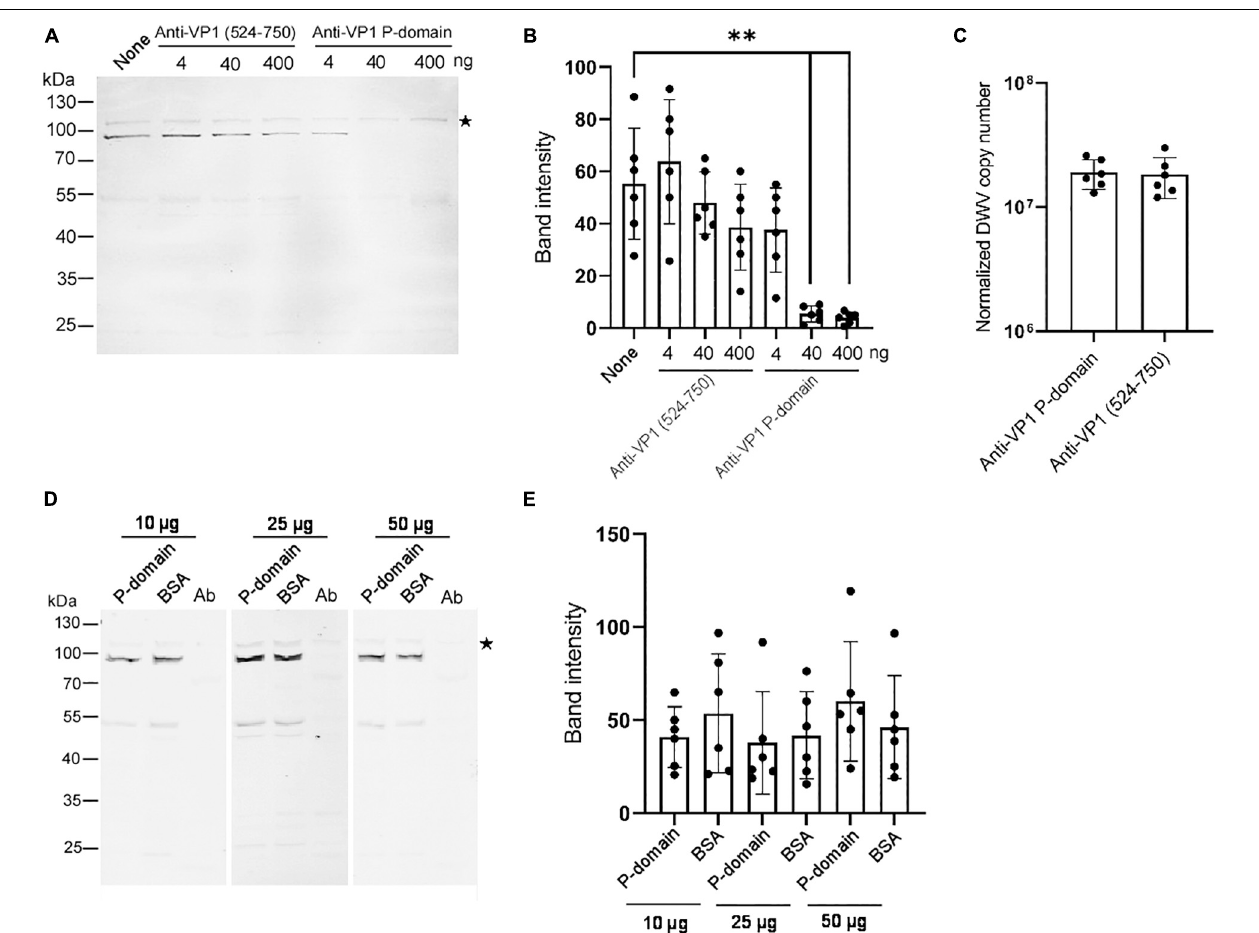
FIGURE 3 | Essential role of the VP1 P-domain in DWV infection. (A) Effect of preincubation of DWV with 4, 40, or 400 ng of either anti-VP1 (524–750) or anti-VP1 P-domain antibody before infection on RdRP synthesis. DWV with no antibody preincubation (none) was used as a control. (B) Band intensity of the RdRP precursor was compared between the seven groups with the one-tailed Dunnett test. P -values between none and 40 or 400 ng of anti-VP1 P-domain antibody are < 8.3 × 10 − 6 and < 5.5 × 10 − 6 , respectively (**). Mean values ± SD (error bars) are shown ( n = 6). (C) Entry of DWV pre-incubated with 40 ng of either anti-VP1 (524–750) or anti-VP1 P-domain antibody to the pupal head tissues was compared (normalized copy number of DWV inside the infected cells). The difference between the two groups was not statistically significant. Mean values ± SD (error bars) are shown ( n = 6). (D) Effect of preincubating pupal head tissues with 10, 25, or 50 µ g of purified P-domain protein before DWV infection on RdRP synthesis. BSA was used as control. Lysate of abdomen from the same pupa (Ab) was also analyzed to confirm the lack of replication of endogenous DWV. (E) Band intensity of RdRP precursor was compared between P-domain and BSA with the different amount of protein. The difference between the two groups was not statistically significant. Mean values ± SD (error bars) are shown ( n = 6). *This represents statistical